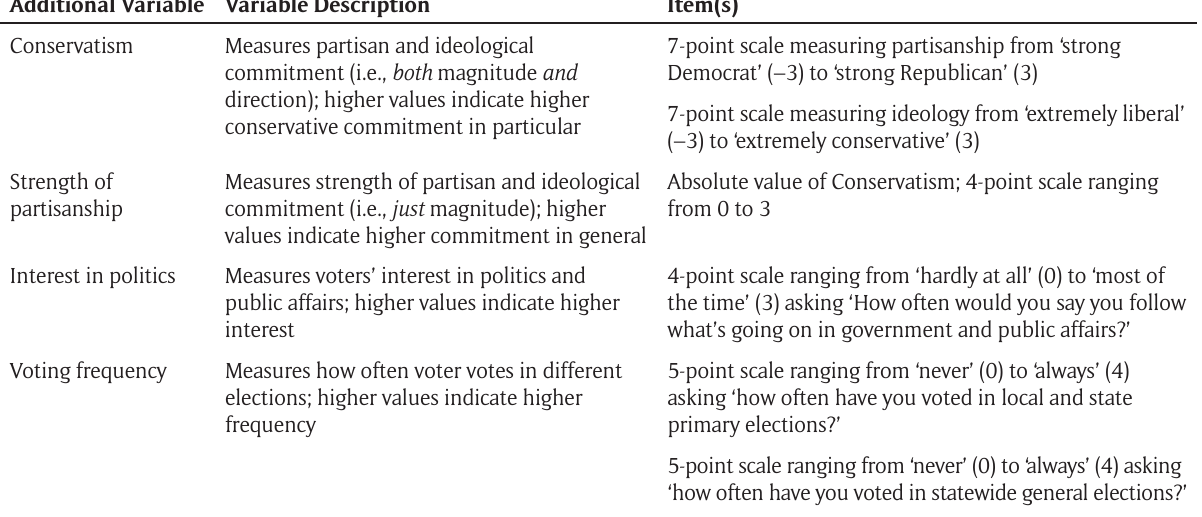
Table 3: Descriptions and Item Wording for Additional